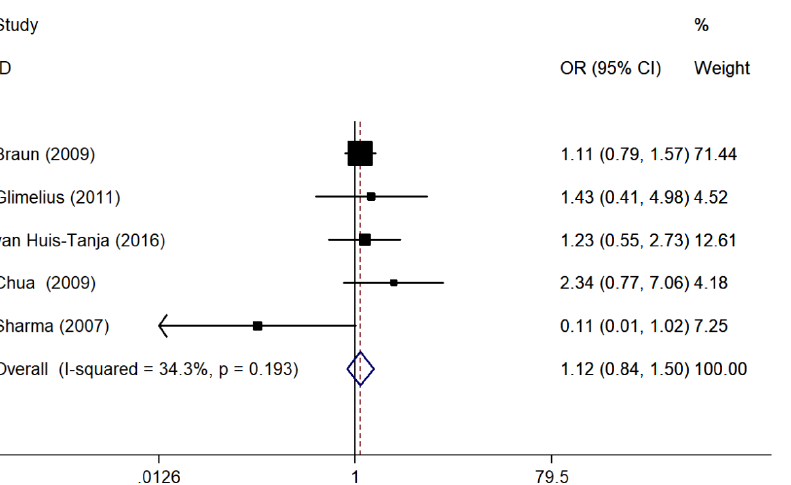
Figure 5: Forest plot of MTHFR gene rs1801133 C>T polymorphisms and grade 3-4 adverse reaction of colorectal cancer in recessive mutation model [TT vs(CT+CC)].